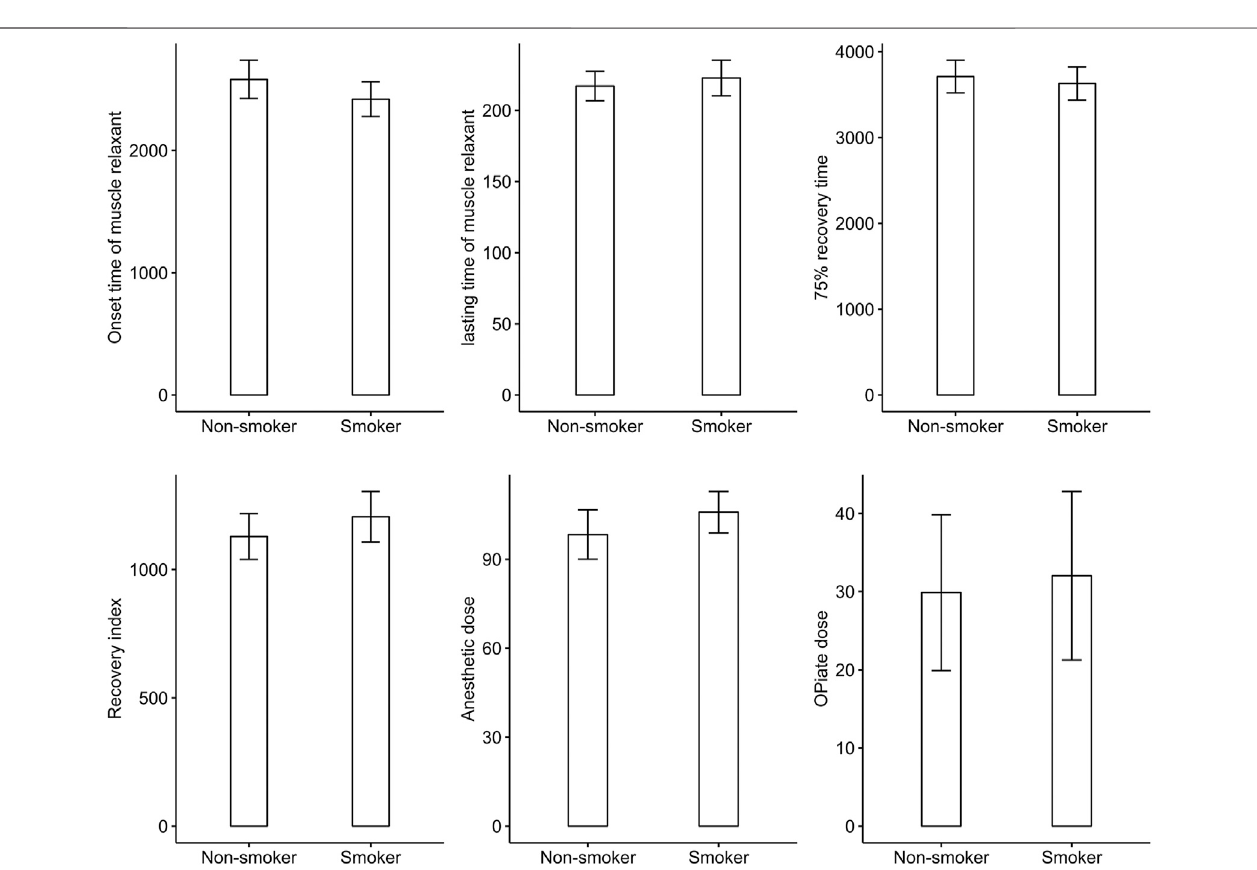
FIGURE 2 | Comparison in anesthesia related parameters between smokers and non-smokers.